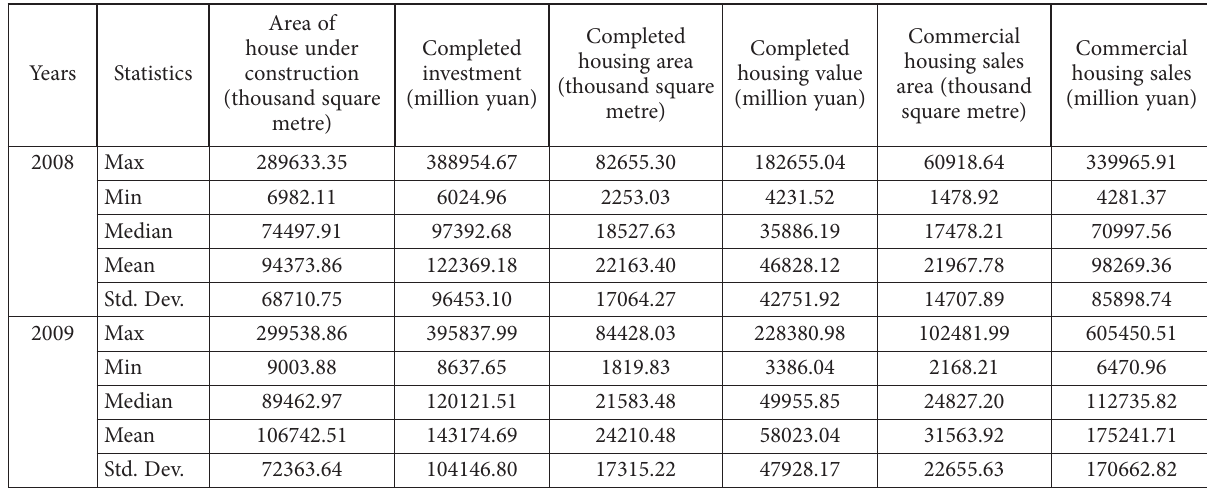
Table A2. Descriptive statistics of the real estate industry in